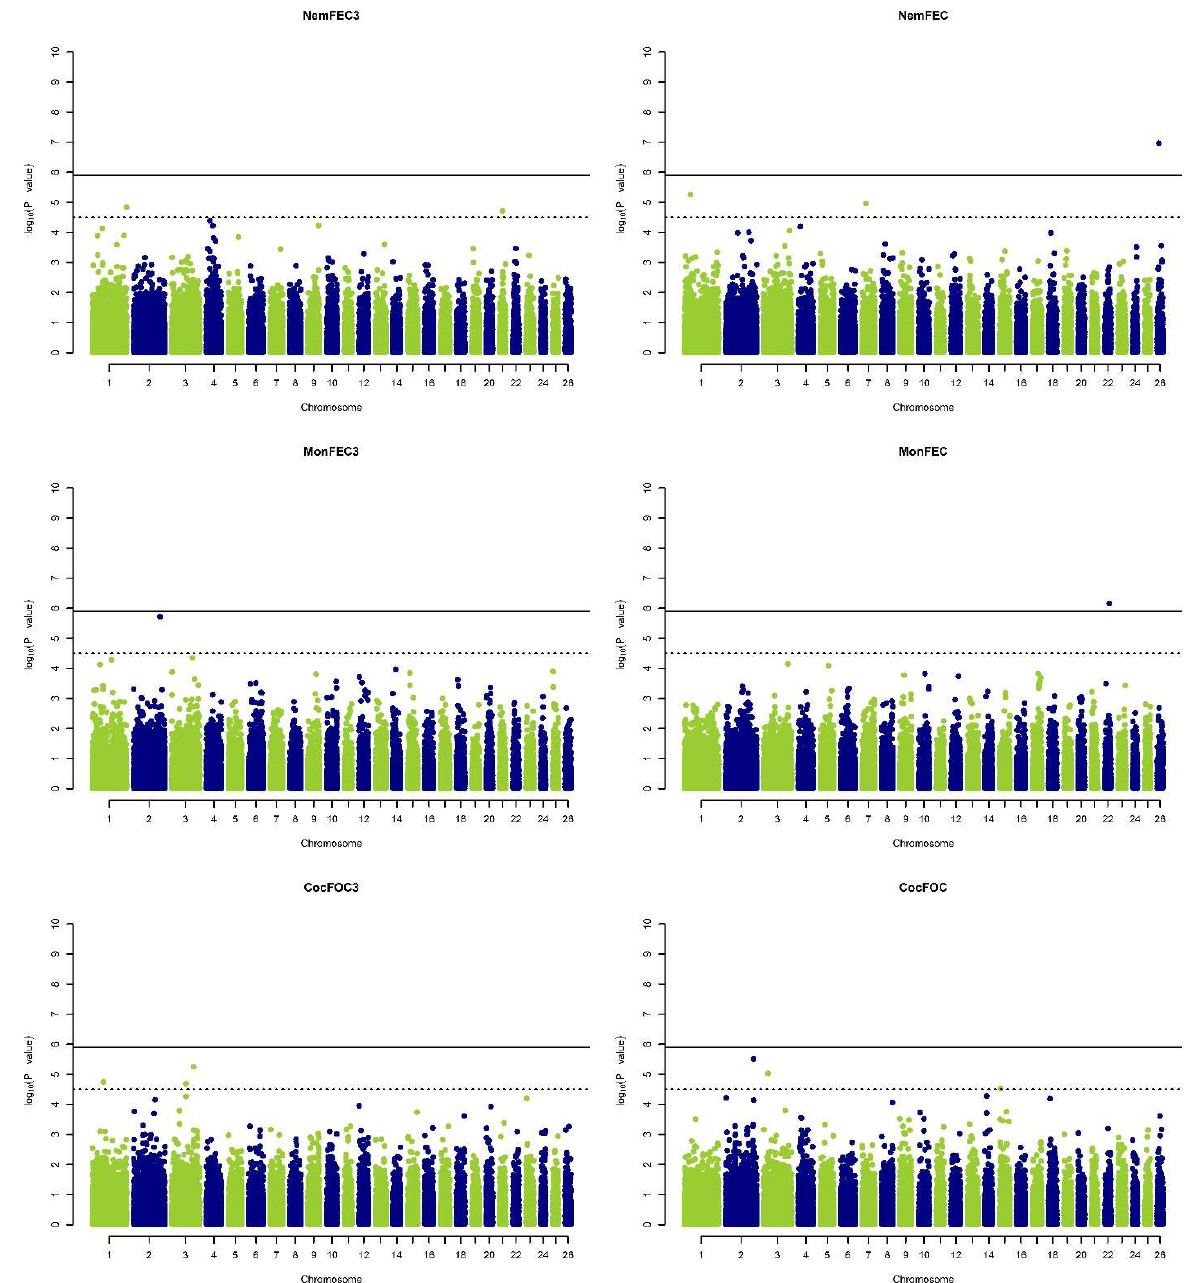
Figure 2. Manhattan plots of six parasite resistance traits. The solid line indicates the genome-wide significance level, and the dashed line indicates the chromosome-wide significance level. Nematode egg count at three months old (NemFEC3), Nematode egg count at six month old (NemFEC6), Tapeworm egg count at three months old (MonFEC3), Tapeworm egg count at six months old (MonFEC6), Eimeria spp. oocyst count at three months old (CocFOC3), Eimeria spp. oocyst count at six months old (CocFOC6). Table 2. Significant SNP associated with parasite resistance phenotypes.